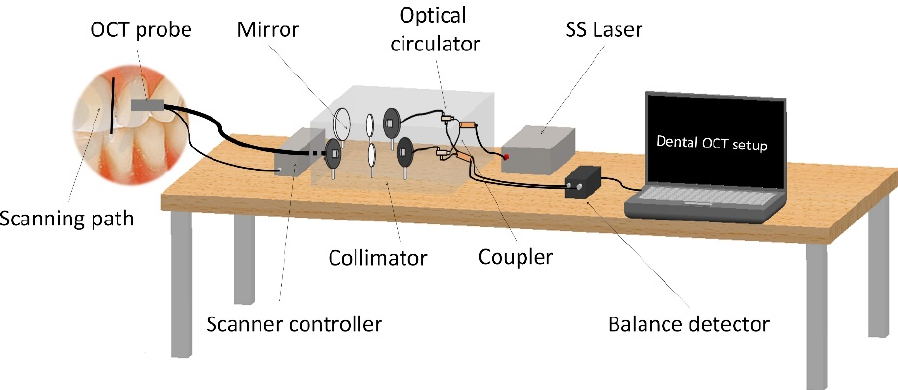
Figure 5. Schematic representation of the setup of a dental handheld probe SS-OCT, for in vivo detection of crack and microleakage, between dental composite resin and enamel (adapted from